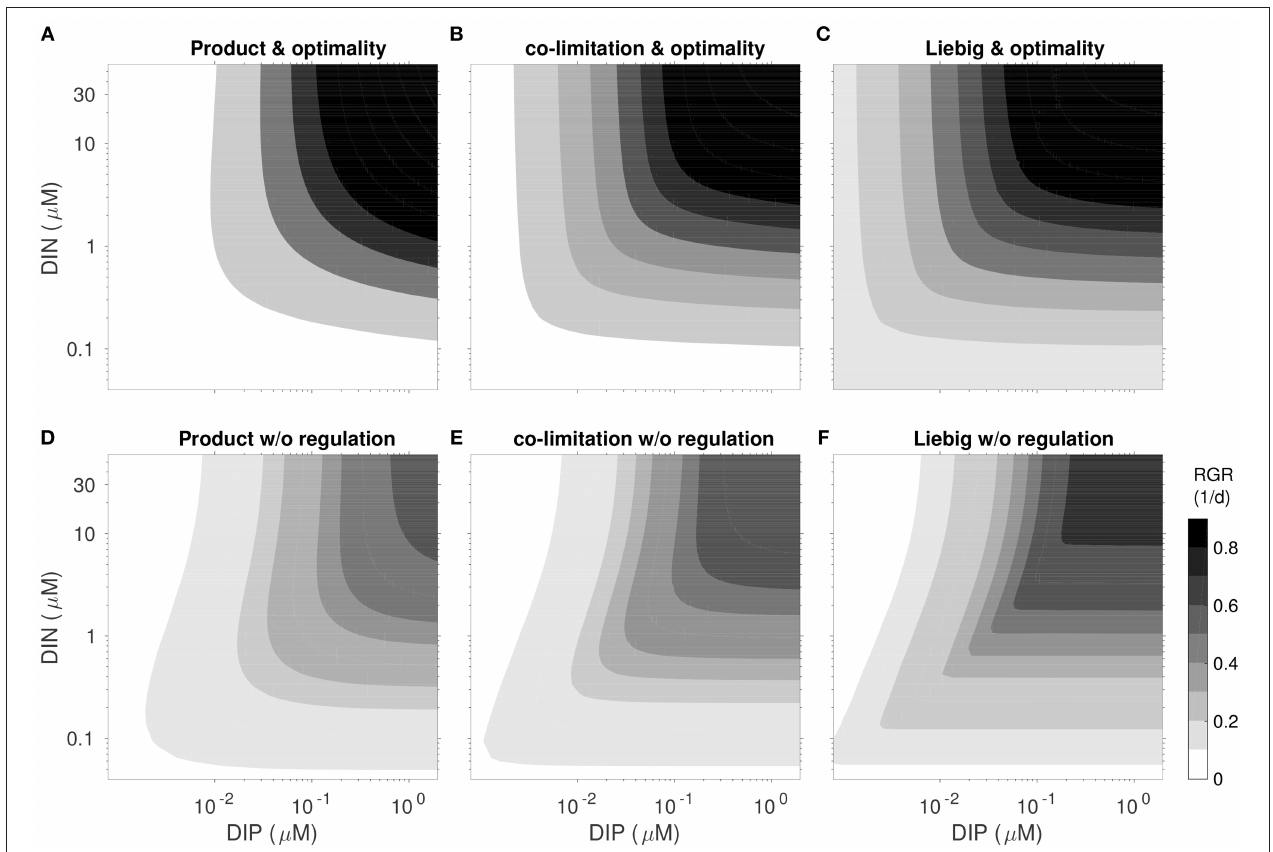
FIGURE 6 | Realized net growth rate RGR = V C − L using the parametrization and light conditions of the S. minutum experiment after 40 days under fixed N- and P-concentration for six different regulation scenarios. ( A–C , top): reference model optimality. ( D–F , bottom): “no regulation” with fixed partitioning and f A i and activities a i linearly bound to quotas as plotted in Figure 5 . Network independence n increases from left to right: “Product” type co-limitation ( A,D ; n = 0.5), variable co-limitation ( B,E ; reference Equation 3), and “Liebig” type ( C,F ; n =